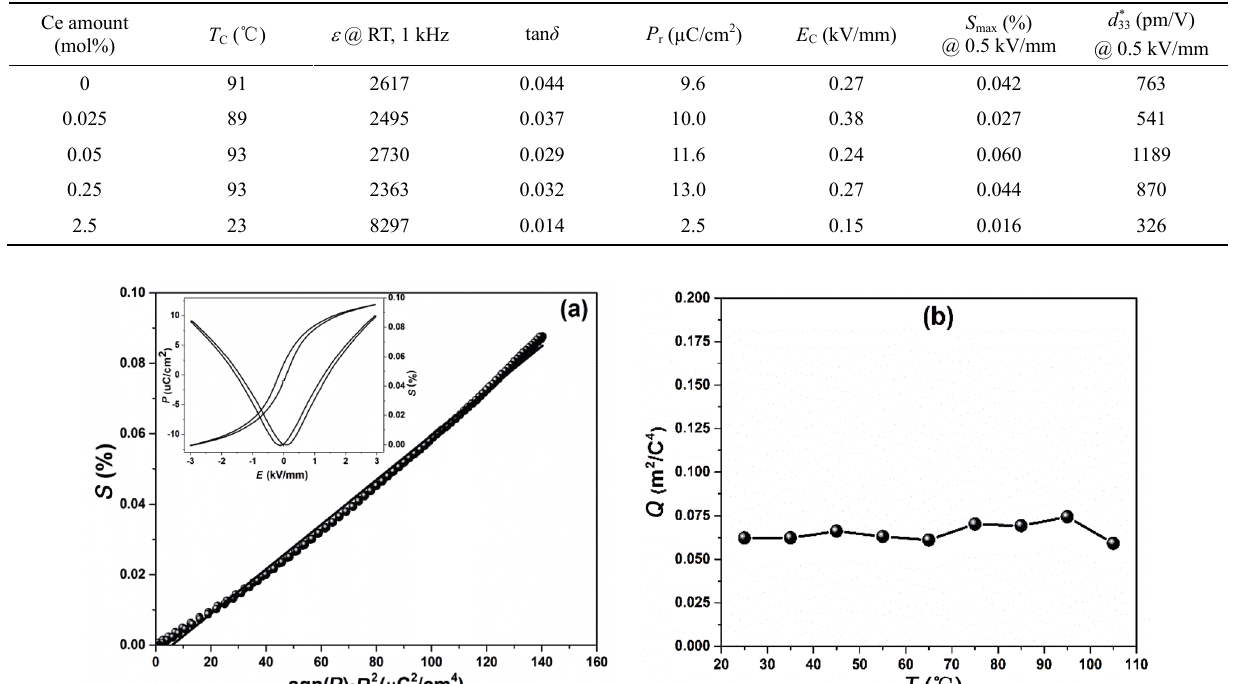
Table 2 Summary of room temperature electrical properties of Ce-doped BCZT samples sintered at 1350 ℃